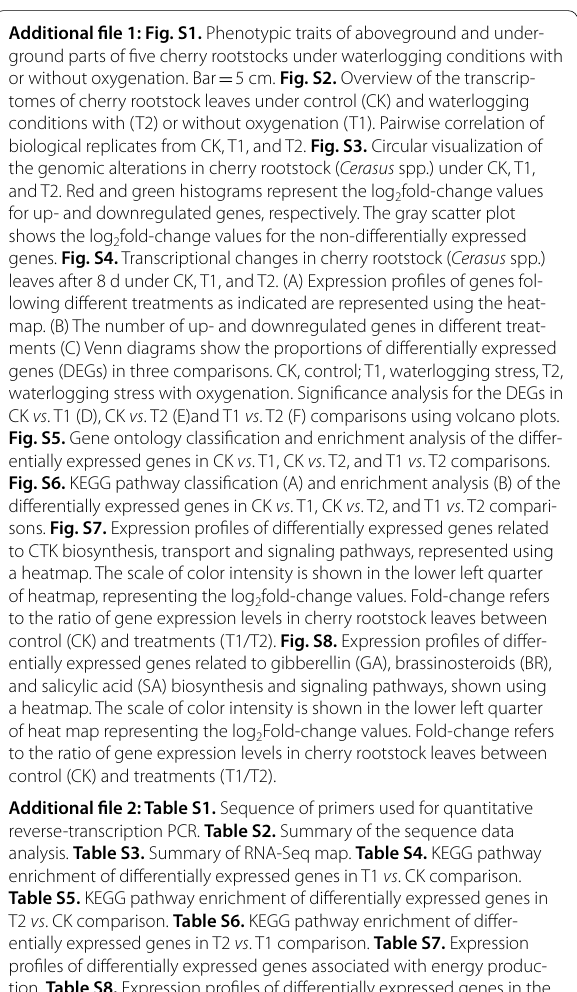
tion. Table S8. Expression profiles of differentially expressed genes in the ethylene metabolic pathway. Table S9. Expression profiles of